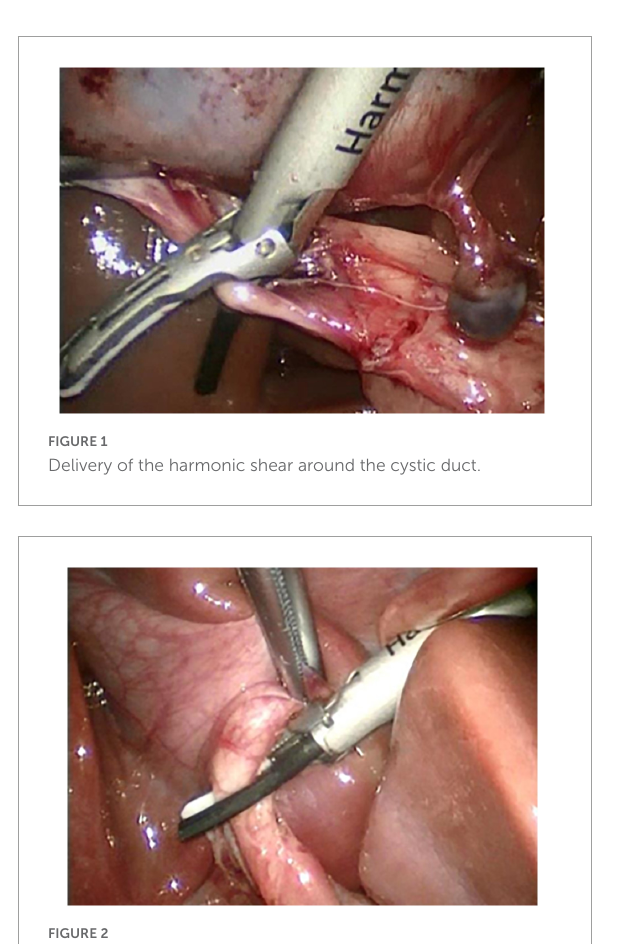
FIGURE2 Cutting of cystic duct with harmonic shear.